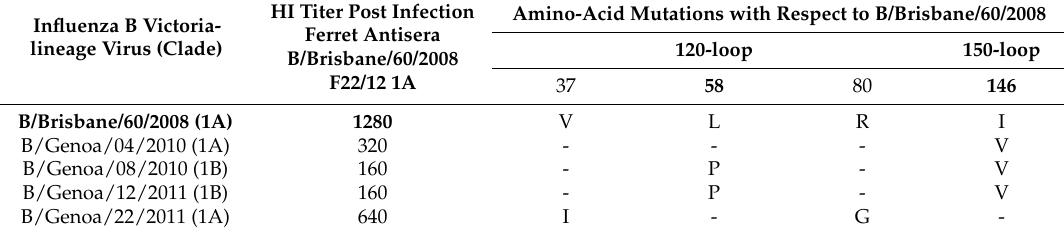
Table 2. Antigenic relationships between selected Ligurian Influenza B isolates and B/Brisbane/60/2008 Victoria-lineage reference virus and the deduced amino-acid mutations found on the HA1 coding region with respect to B/Brisbane/60/2008 (reference viruses, homologous titers and epitopes are in bold